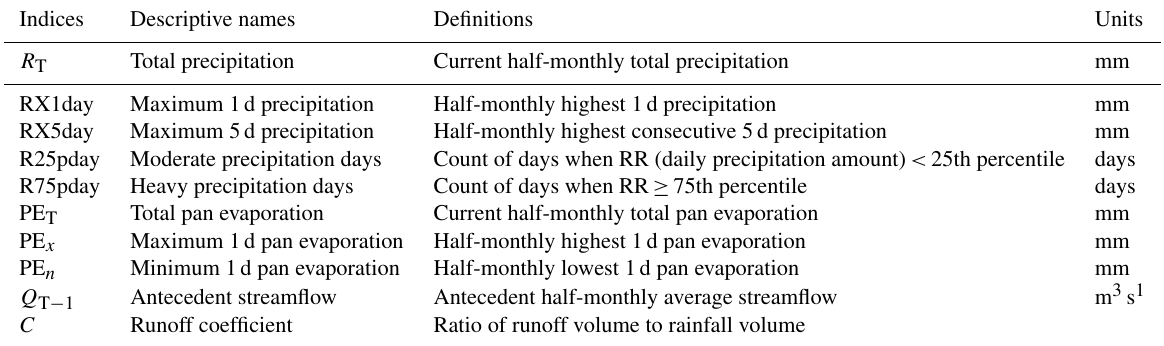
Table A1. Climatic–land surface indices.